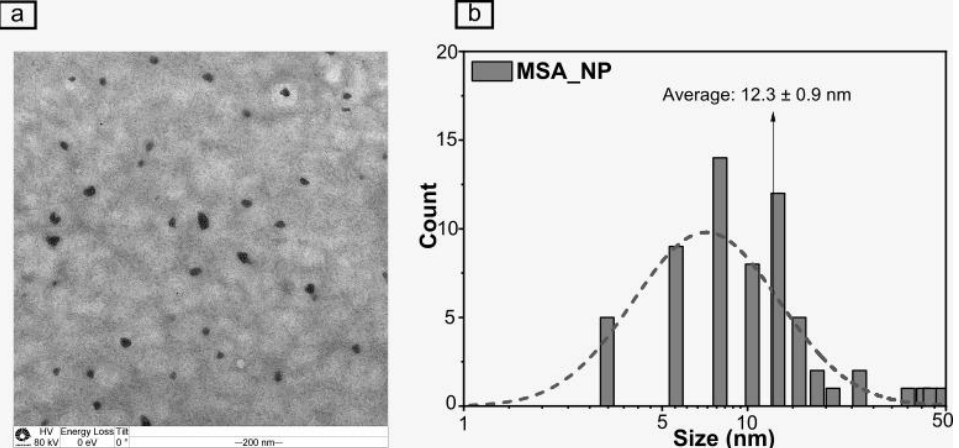
Figure 1. Representative transmission electron microscopy image of the chitosan nanoparticles loaded with mercaptosuccinic acid (MSA_NP) ( a ) and the corresponding size histogram of MSA_NP ( b ).